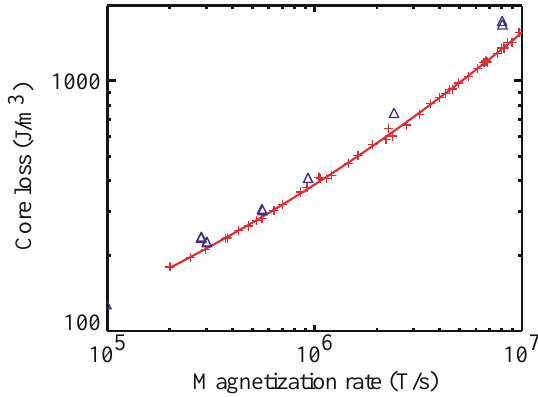
FIG. 9. (Color) Core loss versus magnetization rate for two METGLAS 2605 SC cores, The data are for a flux swing of 2.4 T ( (cid:3) , blue) C12 and ( 1 , red, line) C14.